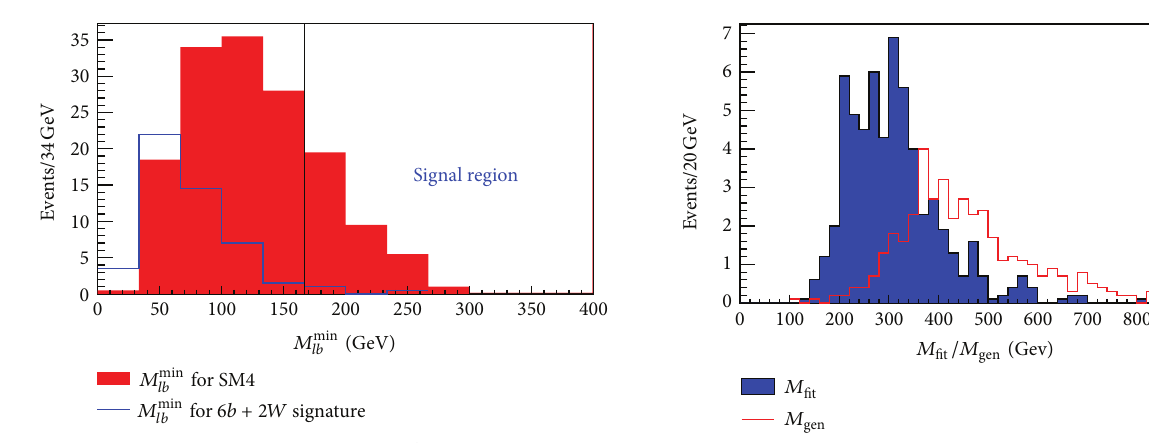
Figure 19: 𝑀 min 𝑙𝑏 for the SM4-like 𝑝𝑝 → 𝑡 󸀠 𝑡 (red) and for the 4G2HDMI 𝑝𝑝 → 𝑡 󸀠 𝑡 (blue) with 𝑚 𝑡 󸀠 = 350 GeV for a set of 7TeV LHC events with ∫𝐿𝑑𝑡 = 5𝑓𝑏 −1 in the dilepton channel. The black line is plotted at the top mass and the region to the right of this line is the “signal region.” Figure taken from [149].